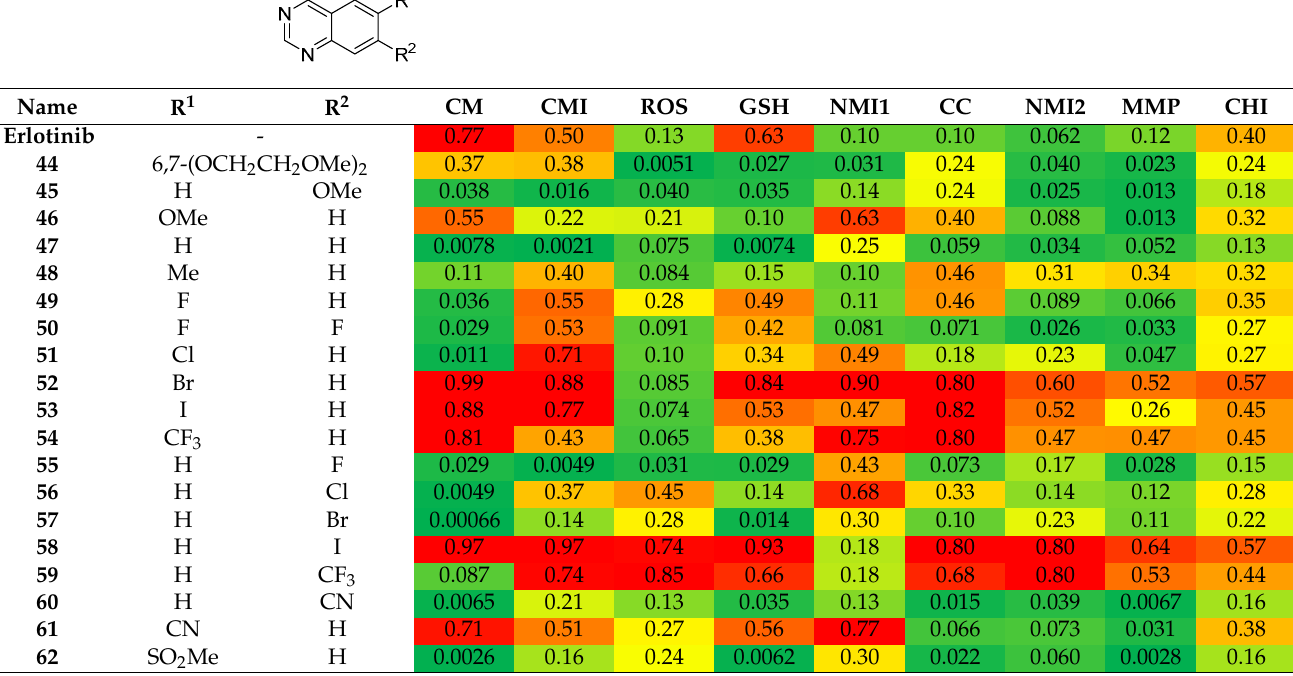
a Abbreviations from columns left to right. CM: Cell morphology; CMI: Cell membrane integrity; ROS: Reactive oxygen species; GSH: Glutathione; NMI1: Nuclear membrane integrity 1; CC: Cell Cycle; NMI2: Nuclear membrane integrity 2; MMP: Mitochondrial membrane potential; CHI: Cell Health Index. b Traffic light colouring matching classifier values (Red–Green: high toxicity risk–low toxicity risk). c all n =